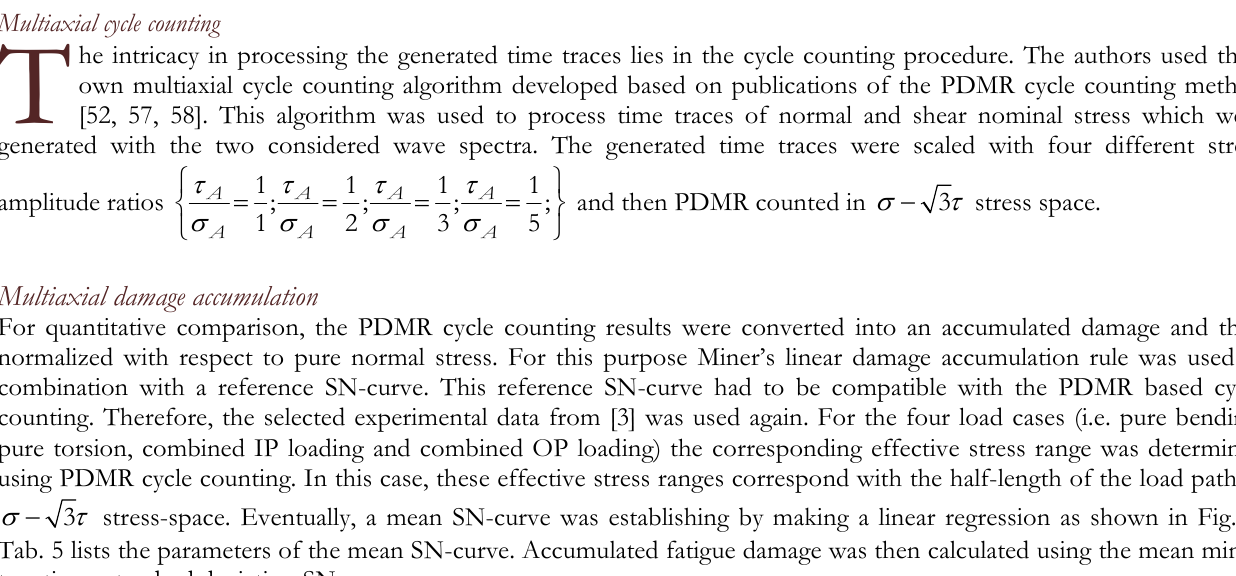
F ATIGUE LIFETIME ESTIMATION